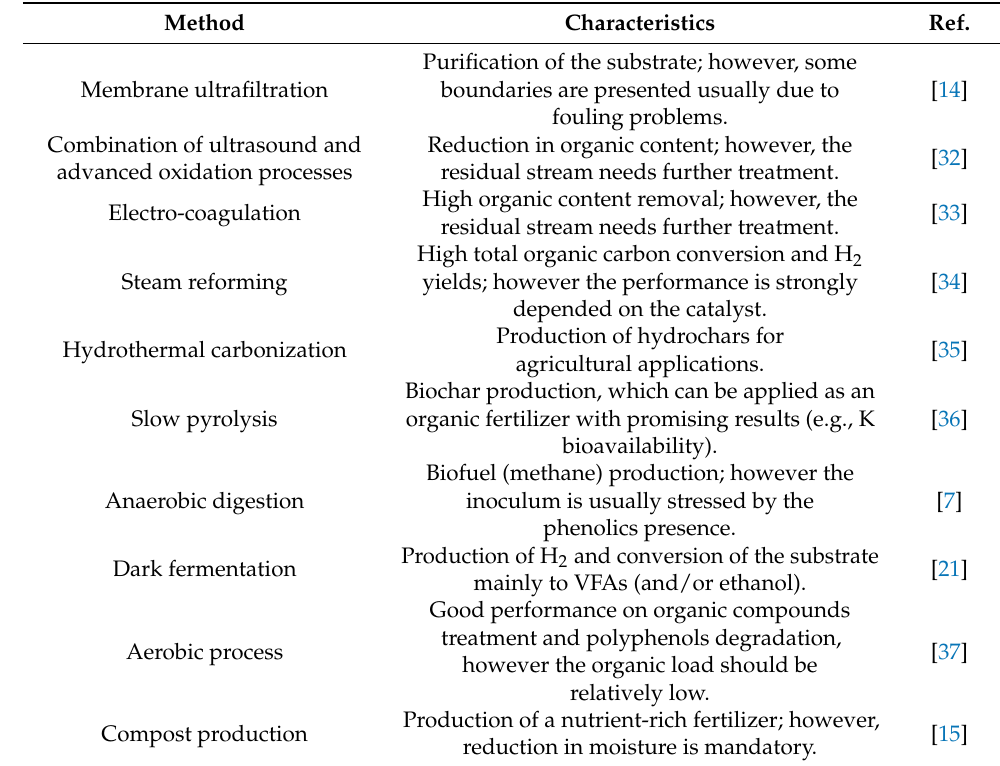
Table 1. Presentation of several methods for OMW valorization/treatment according to the most recent literature and their characteristics. Method Characteristics